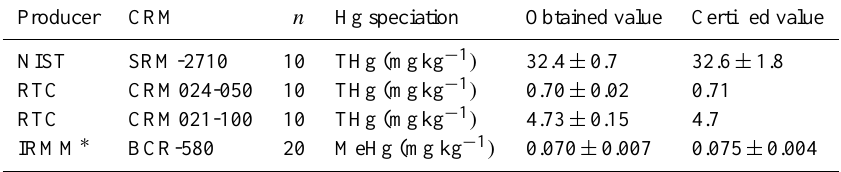
Table 1. List of certified reference materials used in the present study and corresponding analytical result. CRM: certified reference material. Producer CRM n Hg speciation Obtained value Certified value NIST SRM-2710 10 32.6 ± 1.8 RTC CRM024-050 10 THg (mgkg − 1 ) RTC CRM021-100 10